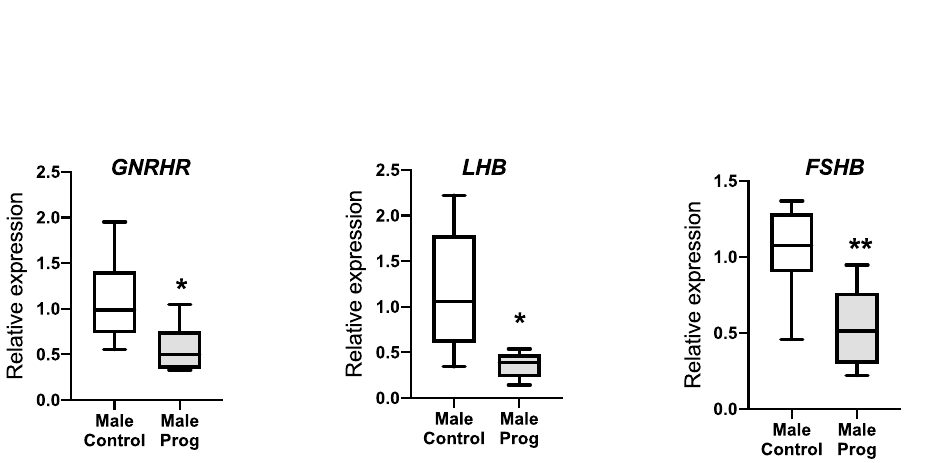
Figure 4. The effect of maternal progesterone on pituitary gene expression in male fetuses at d75 gestation compared to vehicle controls. Maternal progesterone administration decreased expression of GNRHR , FSHB and LHB in fetal males (C = 10; P = 7). Box plot whiskers are lowest and highest observed values, box is the upper and lower quartile, with median represented by line in box. Unpaired, two-tailed Student’s t test was used for comparing means of two treatment groups with equal variances accepting P < 0.05 as significant (* P < 0.05, ** P <